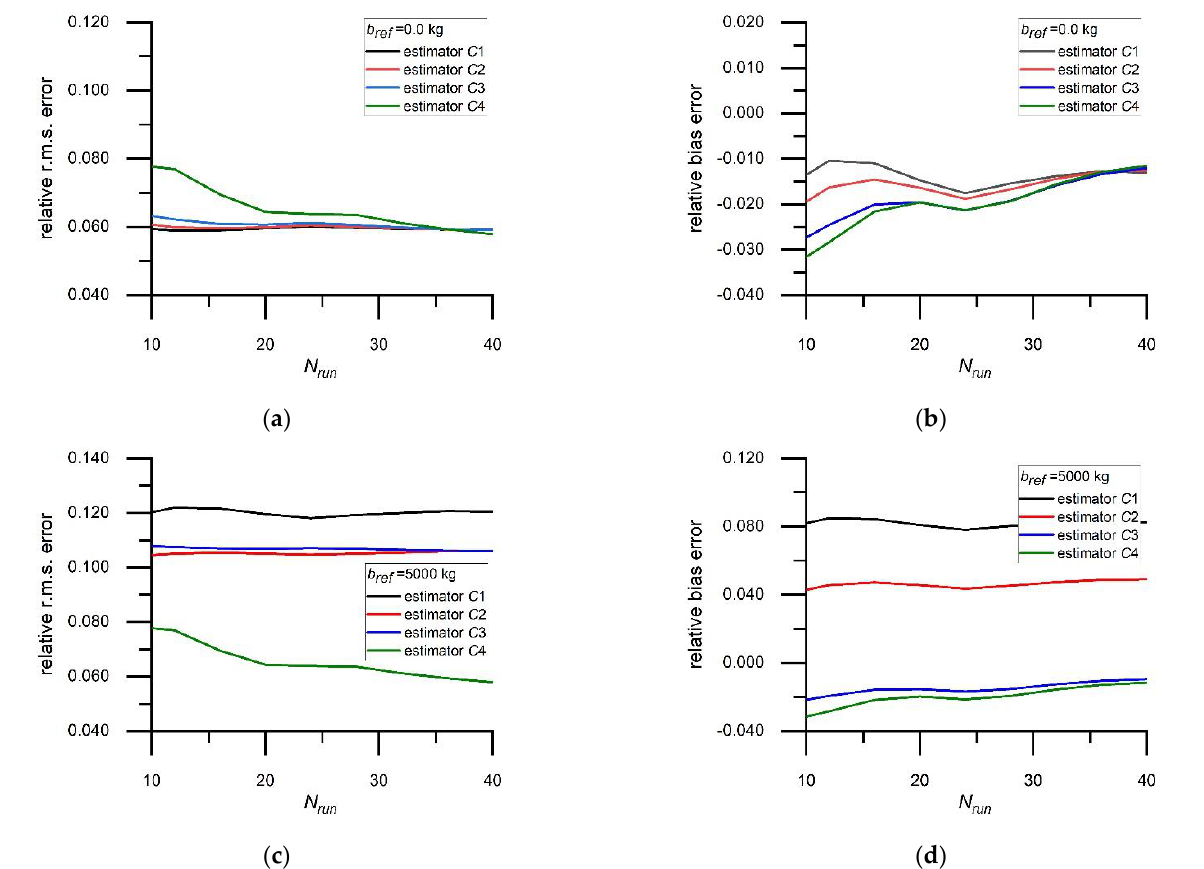
Figure 7. Dependence of weighing errors for the WIM system calibrated according to four discussing estimators on the number of runs of test vehicles 𝑁 𝑟𝑢𝑛 , respectively for ( a , b ) 𝑏 𝑟𝑒𝑓 = 0 kg and ( c , d ) 𝑏 𝑟𝑒𝑓 = 5000 kg.